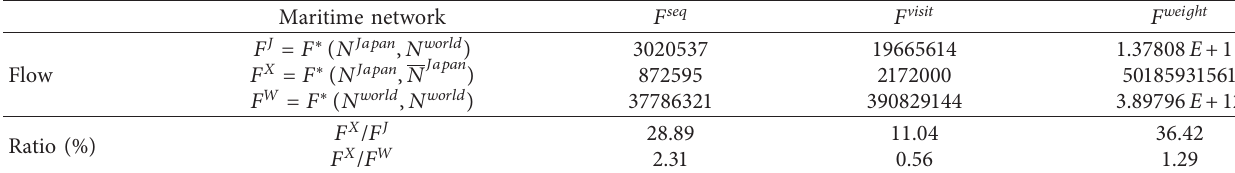
Table 8: Ratios of flows between Japan and the world.